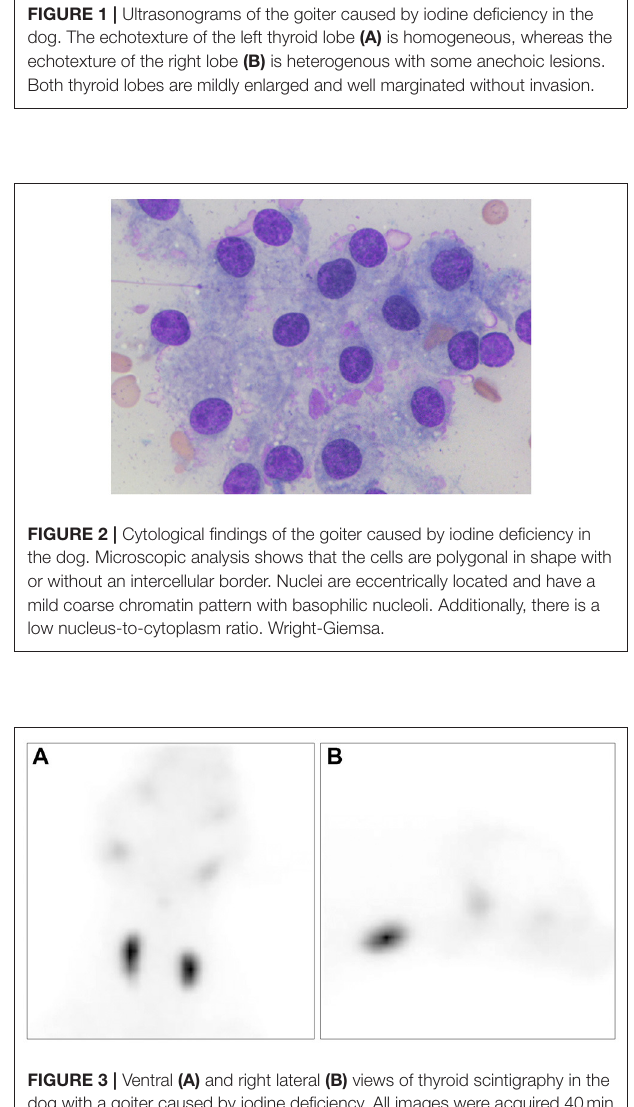
1.0 cm). One year after iodine supplementation, the dog was well with the normal concentrations of thyroid hormones (tT4, 1.8 µ g/dL; TSH, 0.27 µ g/dL) despite a partially reduced goitrous mass (left, 1.6 × 1.1 cm; right, 1.2 × 0.9